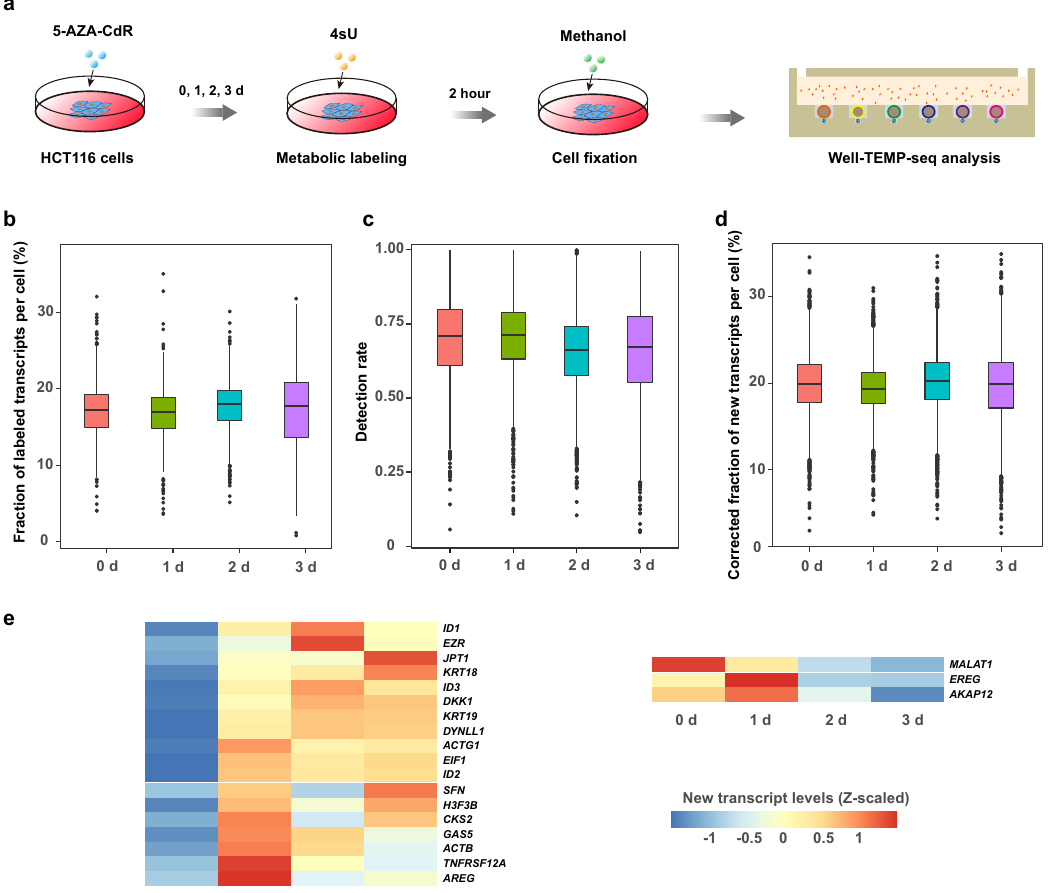
Fig. 3 | Well-TEMP-seq characterizes the transcriptome dynamics of HCT116 cells in 5-AZA-CdR response. a Experimental scheme of characterizing the tran- scriptome dynamics of 5-AZA-CdR-treated HCT116 cells with Well-TEMP-seq. Cells weretreatedwith300nM5-AZA-CdRfor0/1/2/3d.Cellsineachgroupwerelabeled with200 μ M4sU for2hbefore fi xation forWell-TEMP-seq. b Boxplotshowingthe fraction of labeled transcripts per cell in different groups before correction. Here, correction is essential since current metabolic RNA labeling strategies may cause incomplete 4sU labeling of newly transcribed RNAs due to the presence of pre- existinguridineincellsandfalsepositivesarisingfromPCRerrorsandsequencing. c Box plot of detection rate of different groups. Calculated as the ratio between